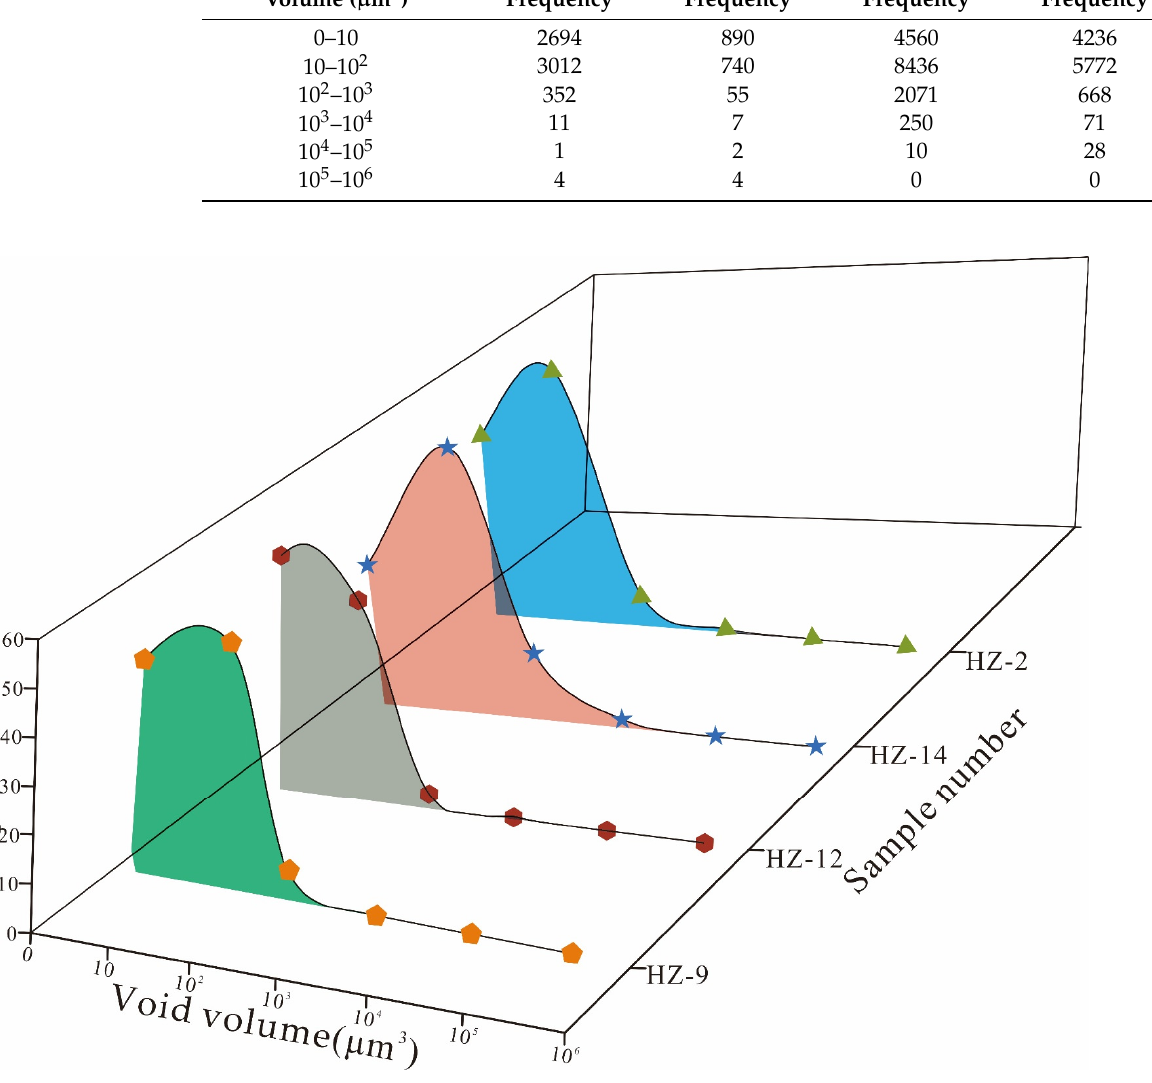
Table 4. Test results of the pore volume of the carbonate rock samples in the Huize lead–zinc de- posit.